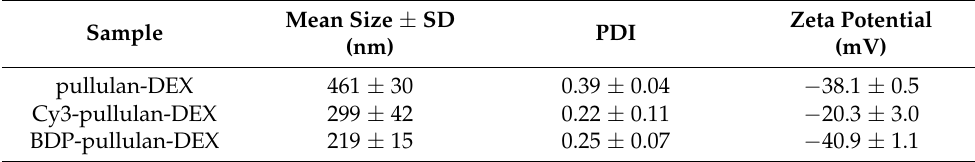
Table 1. Intensity based mean sizes ( ± SD), polydispersity indices (PDI) and zeta potentials of the pullulan conjugate nanoparticles. The measurements were performed by dynamic light scattering. Mean Size ± SD Zeta Potential Sample PDI (nm) pullulan-DEX